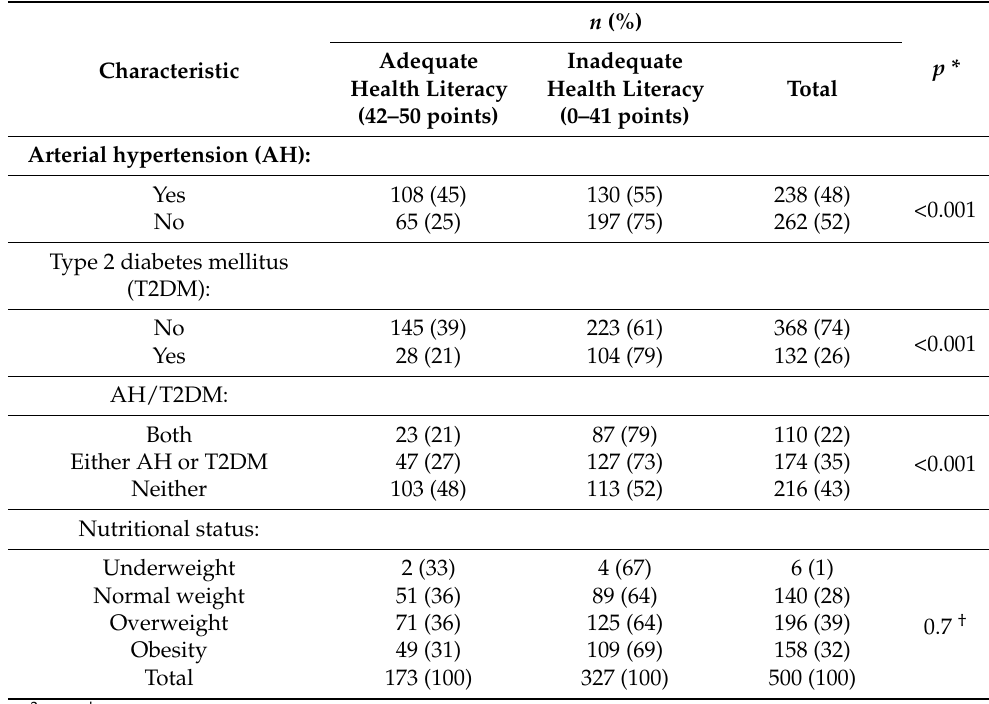
Table 5. Health literacy (SAHLCA-50 score) according to patient characteristic ( n = 500).